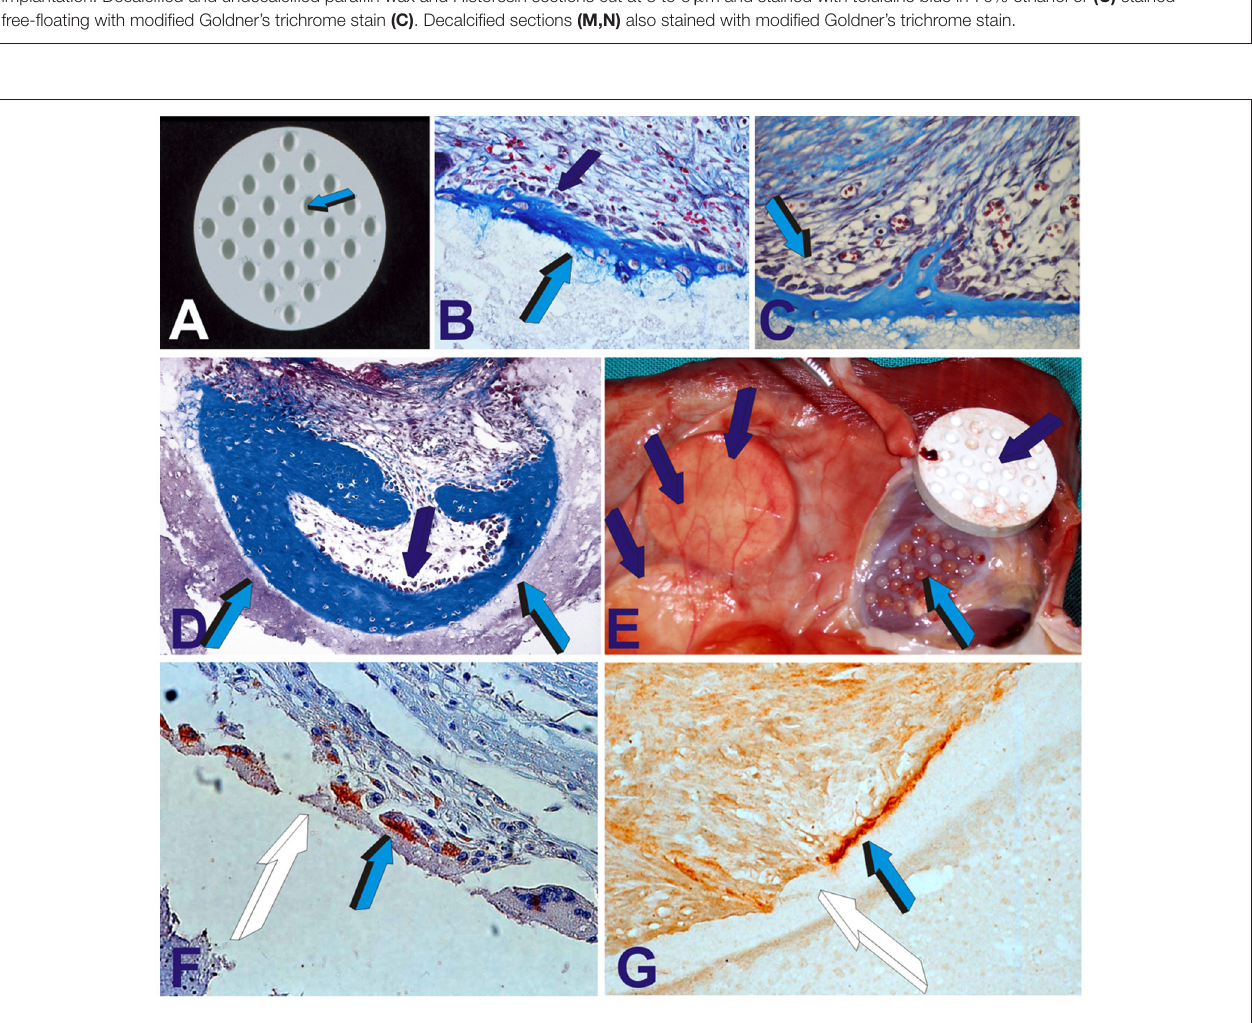
FIGURE 2 | The geometric induction of bone formation: the concavity, the shape of life. Concavities (Ripamonti et al., 1999; Ripamonti, 2006), as prepared in solid discs of highly crystalline sintered hydroxyapatite constructs on both planar surfaces (Ripamonti et al., 1999), (A) spontaneously initiate the induction of bone formation on day 30 after rectus abdominis implantation (B,C) . The newly formed intramembranous bone is tightly attached to the hydroxyapatite biomatrix ( B light blue arrow) anchoring into the hydroxyapatite substratum (B,C) . On day 90 (D) ,the newly formed bone within the concavity (light blue arrows) remodels still surfaced by contiguous osteoblasts (dark blue arrow) continuously secreting bone matrix. (E) Tissue harvest of highly crystalline sintered constructs (dark blue arrows) implanted in the rectus abdominis muscle. Highly vascularized mesenchymal tissue (light blue arrow) had grown within the concavities of the harvested sintered construct (dark blue arrow). (F) On day 30, differentiating cells at the hydroxyapatite interface express bone morphogenetic protein-7 (also known as osteogenic protein-1, OP-1) within the cytoplasm (light blue arrow) later embedded as gene product (G) (light blue arrow) within the microstructure of the hydroxyapatite biomatrix (white arrows).